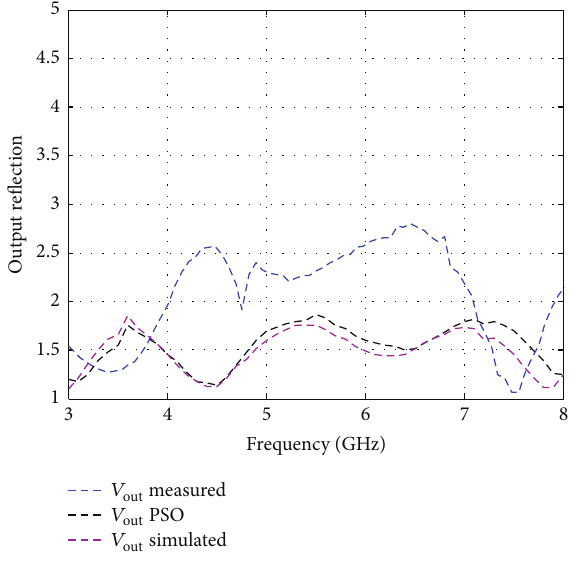
Figure 12: Comparative results for output VSWR of designed amplifier.